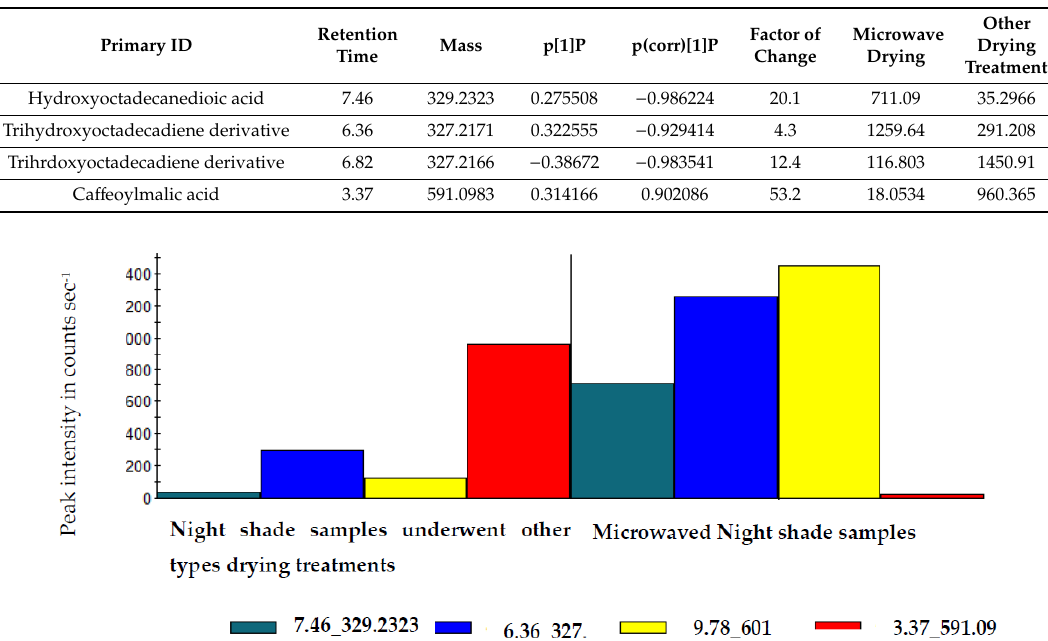
Figure 2. Histogram illustrating quantitative differentiation of biomarkers, between traditional sun drying and other drying treatments (traditional sun, solar, oven, and freeze-drying) of Chinese cabbage leaves. Table 8. Exact Mass / Retention Time pairs responsible for the separation of microwave dried Nightshade leaves and other samples that underwent solar, oven, microwave and freeze-drying treatments.